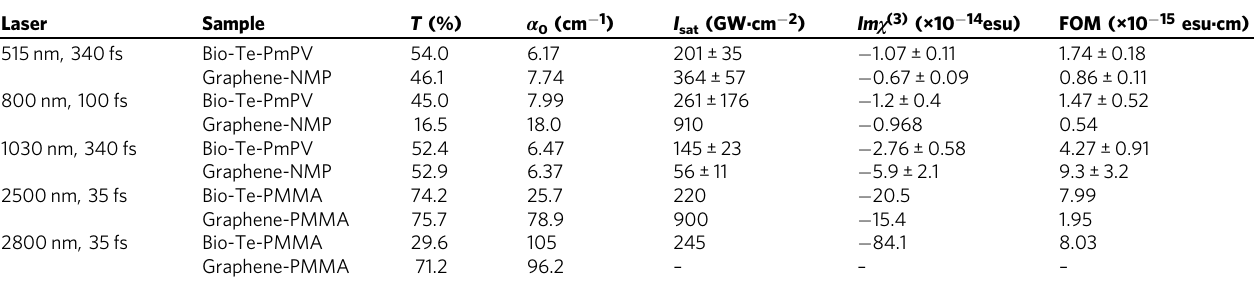
Table 1 Nonlinear optical coef fi cients of biological synthesized tellurium Laser